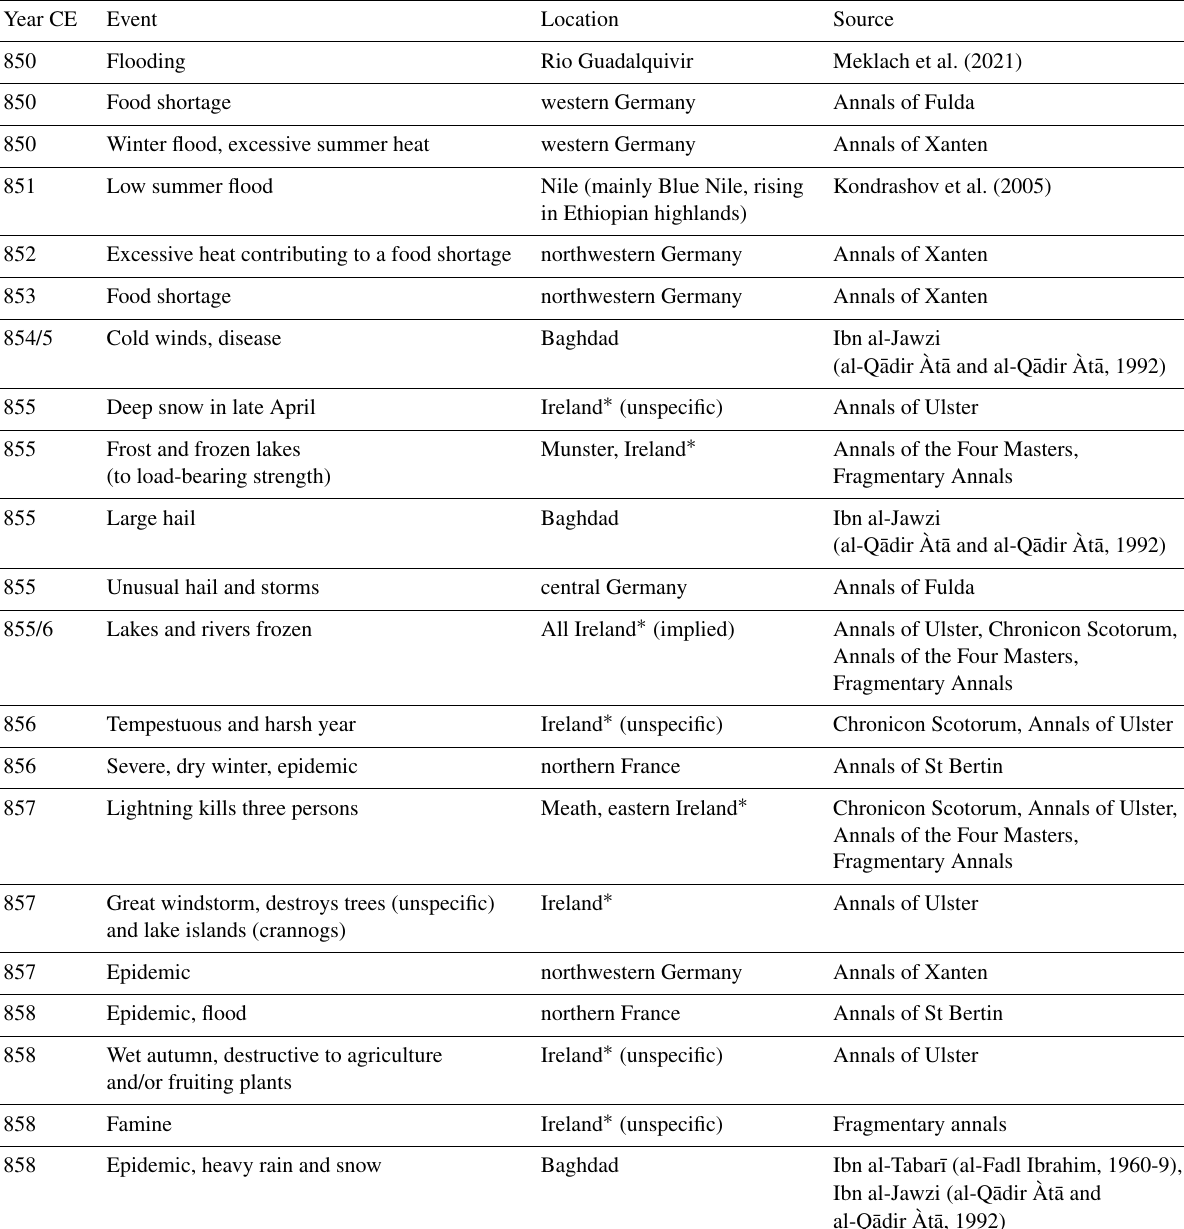
Table 1. Climate and climate-related events recorded in Irish, Carolingian, Anglo-Saxon, Byzantine, Italian, Iberian, Abbasid and Egyptian sources between 850 and 858CE. Locations given reflect where the texts were likely compiled at the time, though the phenomena recorded could have been more widespread. Cases were the phenomena locations are instead given are denoted by an asterisk ( ∗ ). Inventories of all sources from Ireland are provided in Ludlow (2010). Inventories of all sources from Germany and France are provided in Newfield